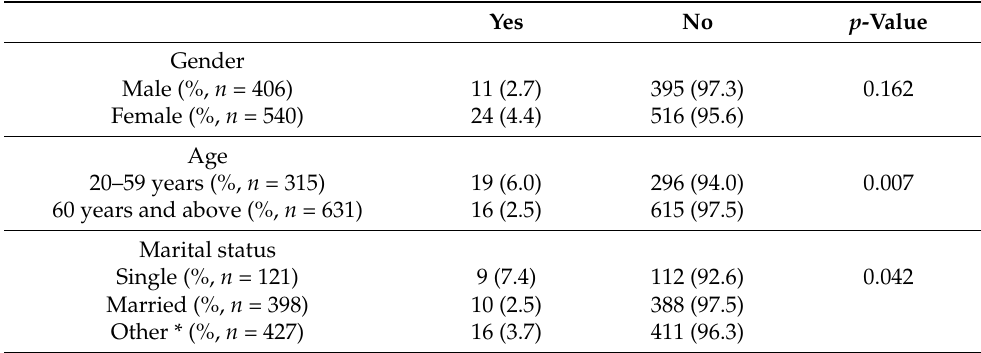
Table 3. The demographic characteristics of advance care planning participants with health care agents in Taipei Veterans General Hospital in 2019.